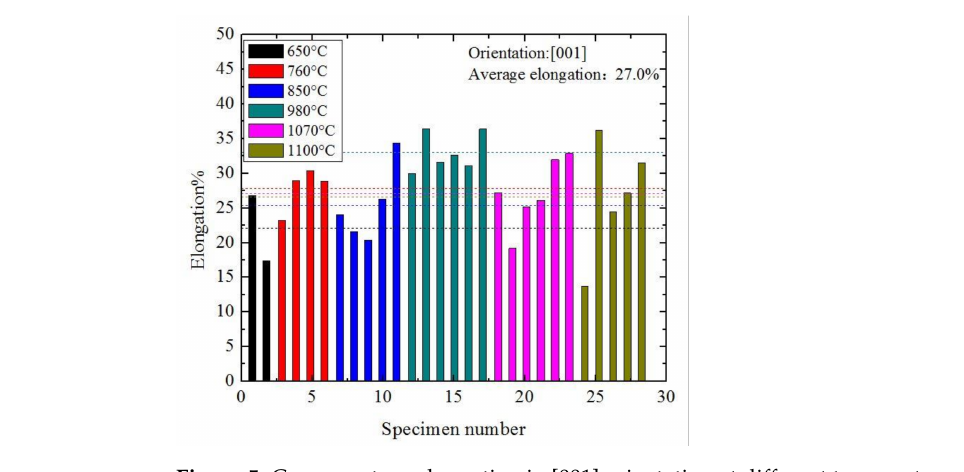
Figure 5. Creep rupture elongation in [001] orientation at different temperatures and different stress levels adapted from reference [24].